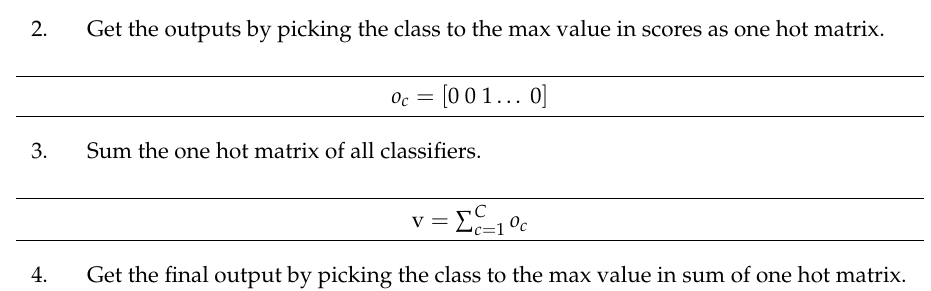
Table 2. Ensemble method of score